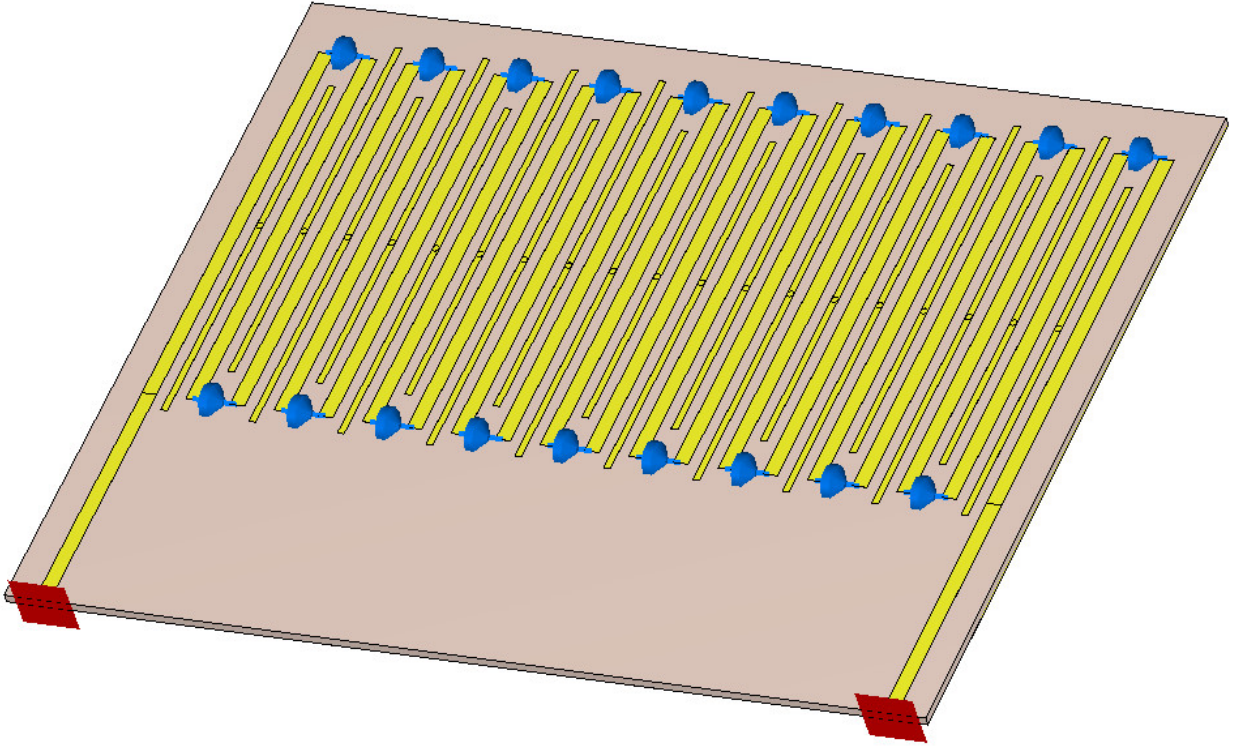
Figure 2. Three-dimensional view of hybrid meander structure with grounded in the middle additional shields in CST Microwave Studio®.